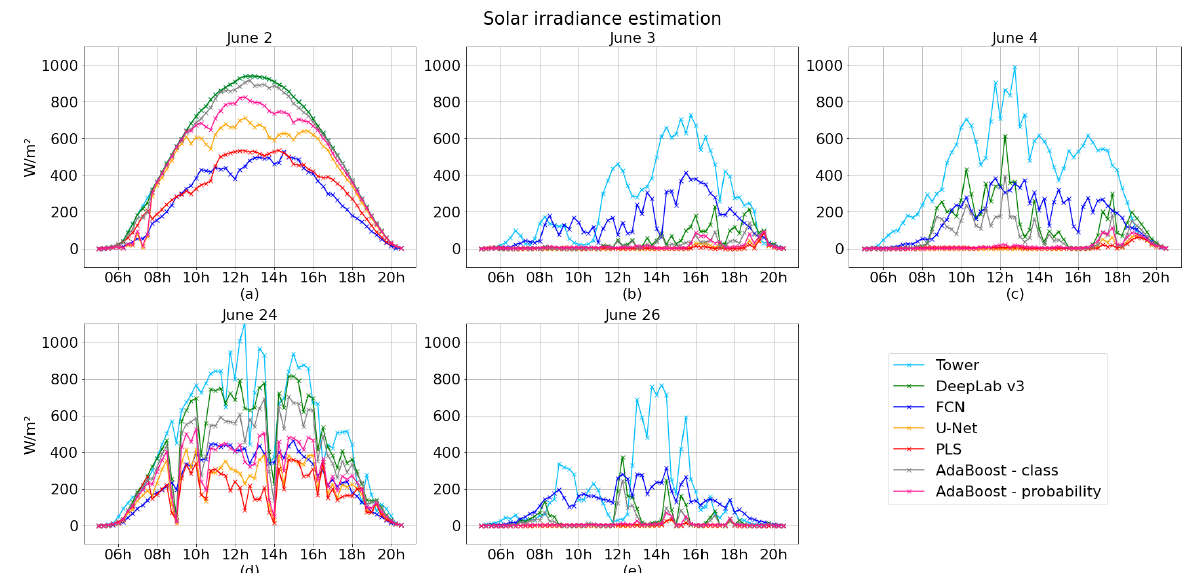
Figure 5. Measured solar irradiance (light blue) and solar irradiance estimation results in W/m 2 using 15 min averaged cloud cover estimation and maximum solar irradiance measured on 2 June 2020 for five days with ( a ) clear sky, ( b , c ) haze clouds, ( d ) partially cloudy sky, and ( e ) overcast clouds. The tower measure on 2 June ( blue line ) is overlapped with the DeepLab v3 estimation results ( green line ), with only a small difference between these observable at 7–8